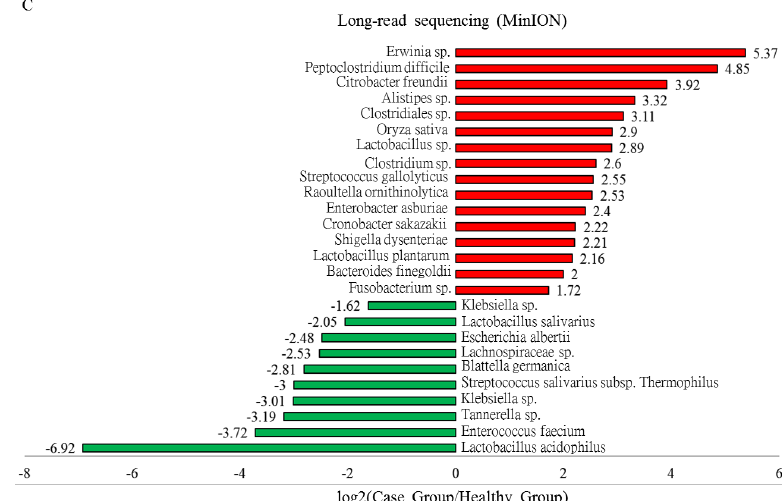
Figure 4. Distinct composition of microbial community of the healthy group and the case group with short- and long-read sequencing results. ( A ) The relative levels of top 25 classified taxa in these two groups with short-read sequencing data. ( B ) Increases (red bar) or decreases (green bar) in the differential abundance of identified taxa in Case group as compared to the healthy group with MiSeq data. ( C ) Increases (red bar) or decreases (green bar) in the differential abundance of identified taxa in Case group as compared to the healthy group with MinION results.